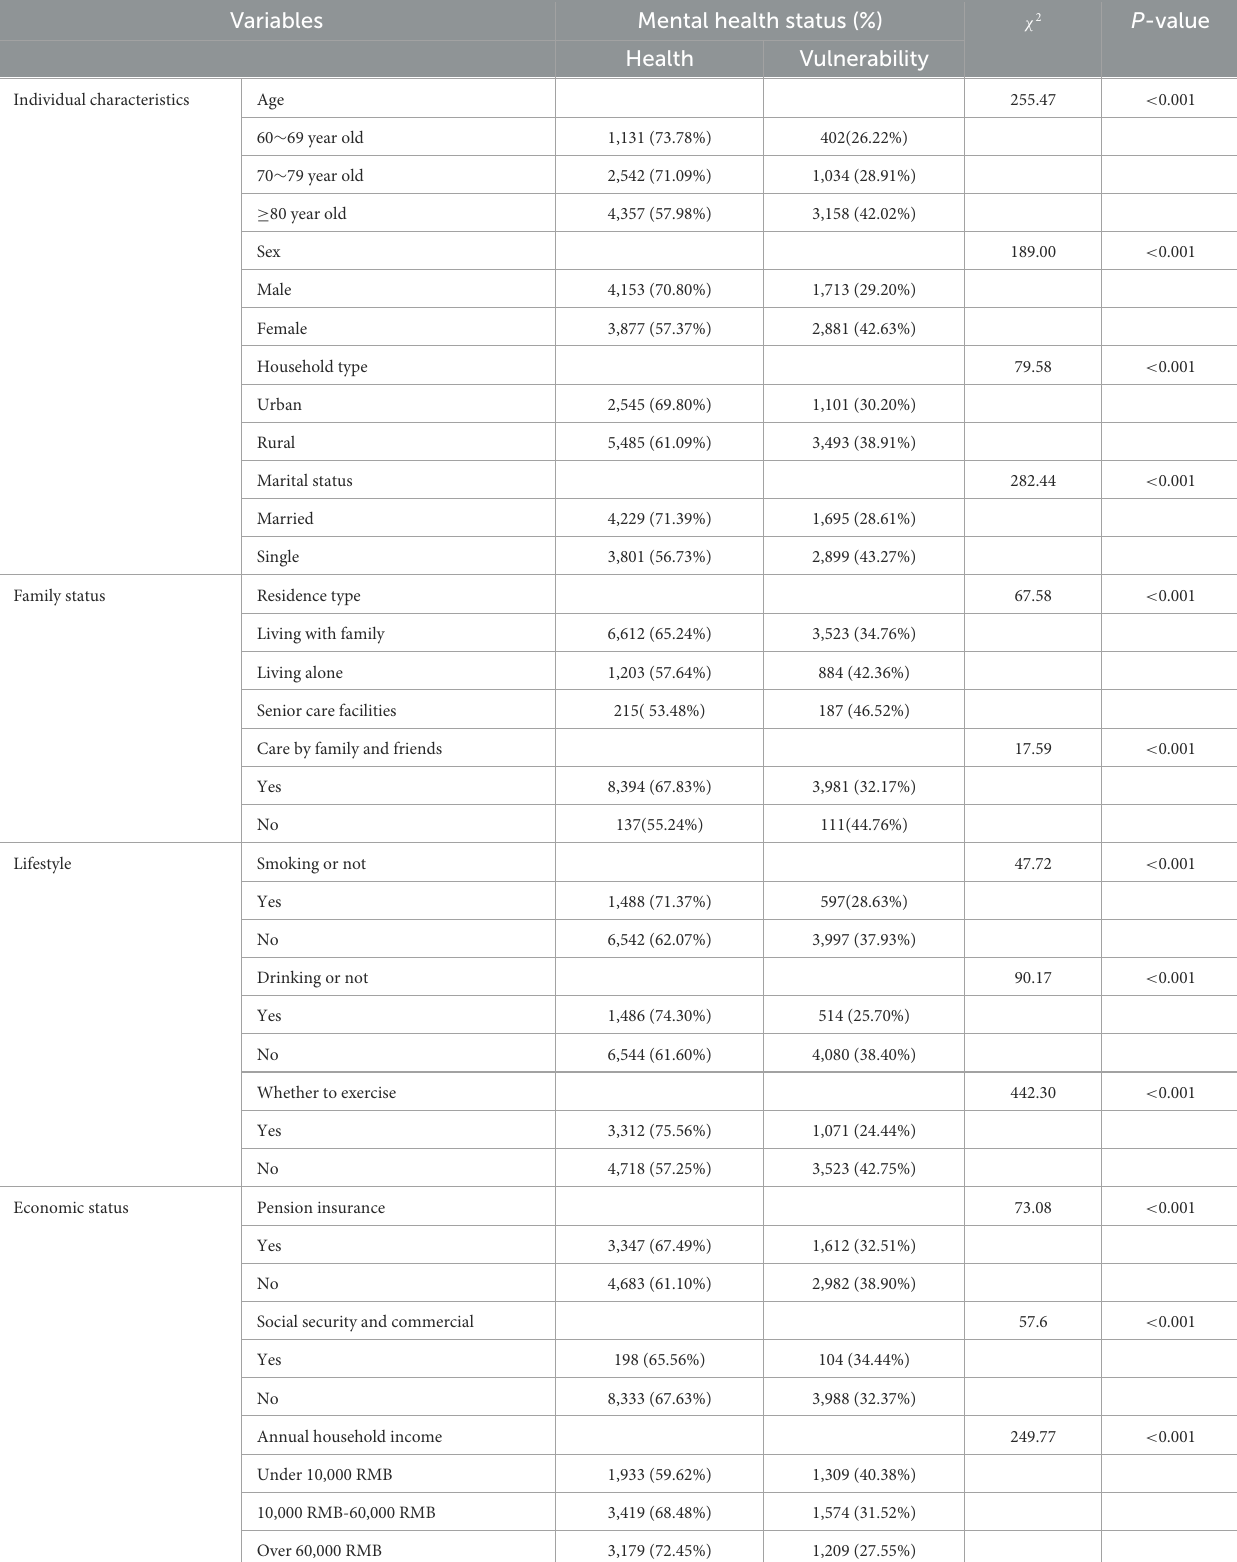
TABLE 4 Basic mental health status of different older adults. Variables Mental health status (%) χ 2 P -value Health